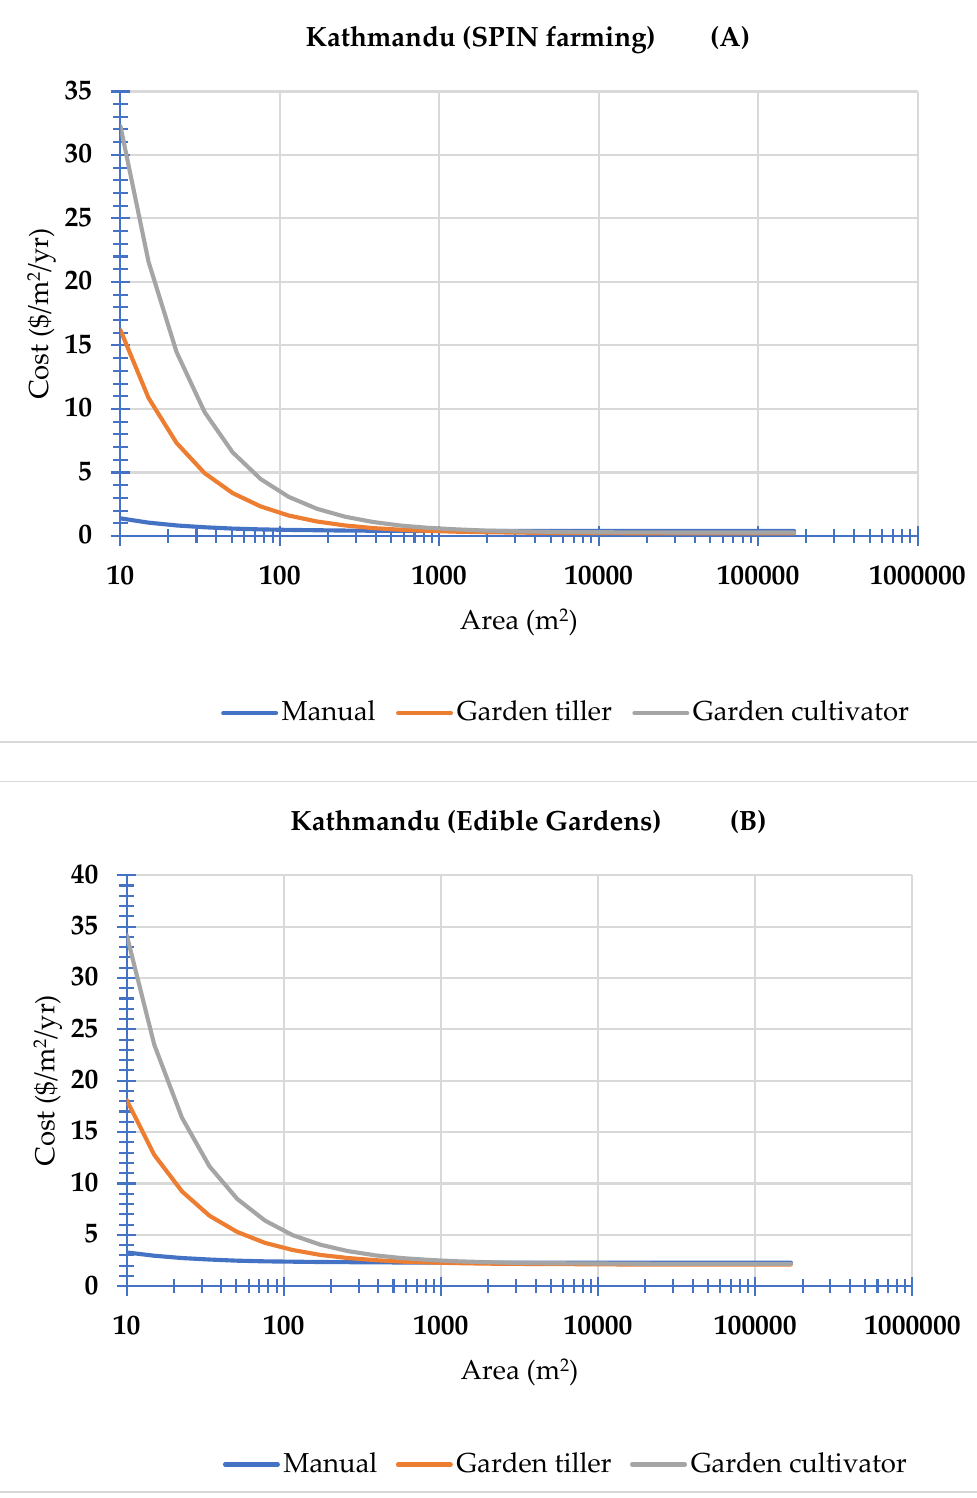
Figure 7. ( A , B ). The economy of scale calculation in Kathmandu Valley.